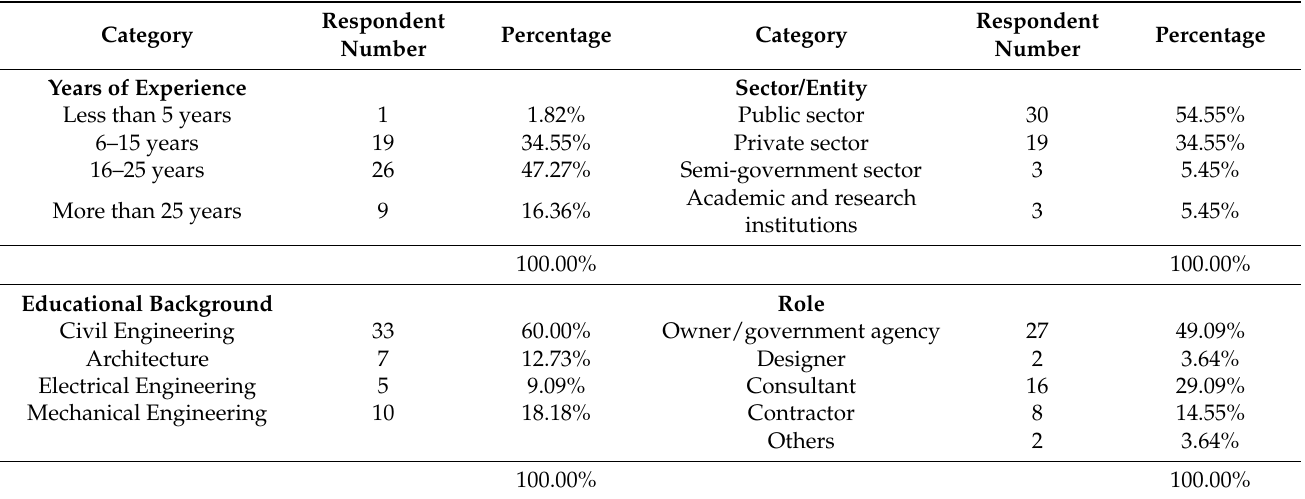
Table 1. Participants’ demographic